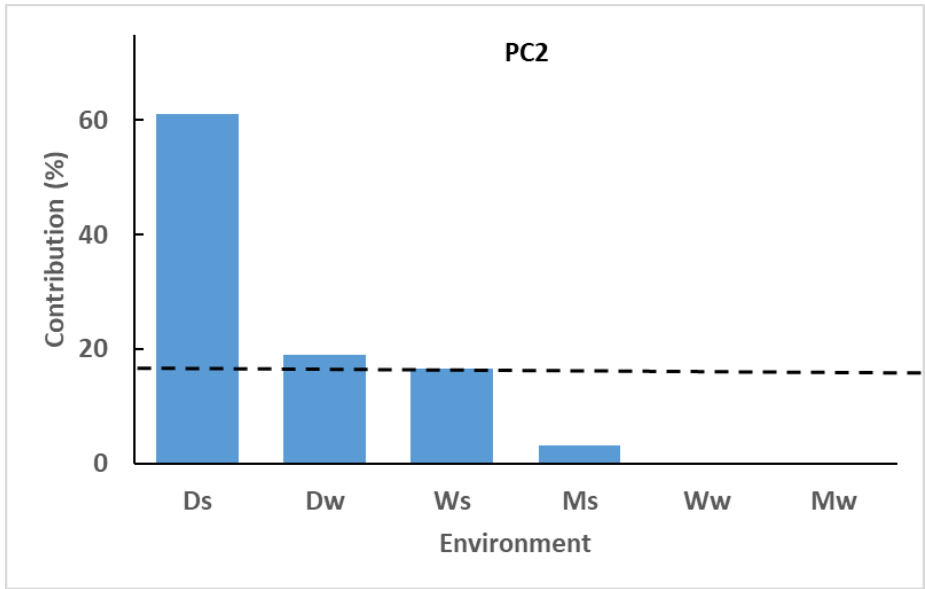
Figure 3. Individual contribution of environments to PC1 and PC2. Ds = Poorly watered in summer; Dw = Poorly watered in winter; Ms = Moderately watered in summer; Mw = Moderately watered in winter; Ws = Well-watered in summer; Ww = Well-watered in winter. The dashed lines indicate the expected average contribution, so that all contributors larger than this cut-off are considered as important to the respective component.